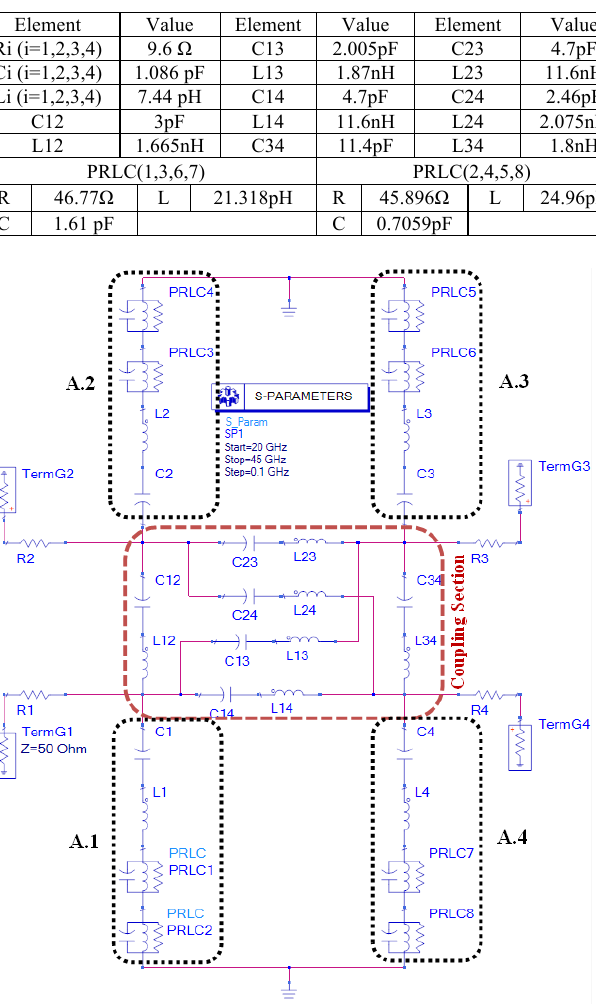
FIGURE 2. Equivalent circuit diagram of the MIMO antenna plotted using